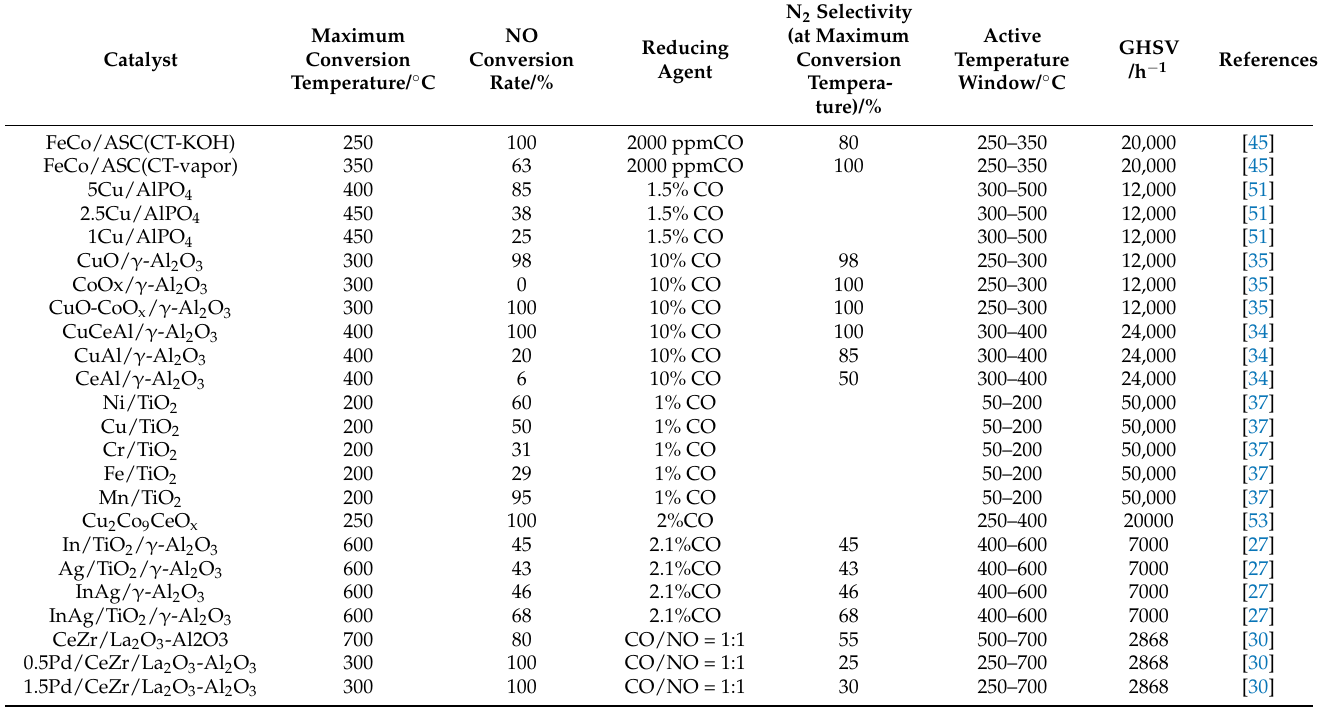
Table 1. Catalysts for catalytic reduction of NO x by CO under different